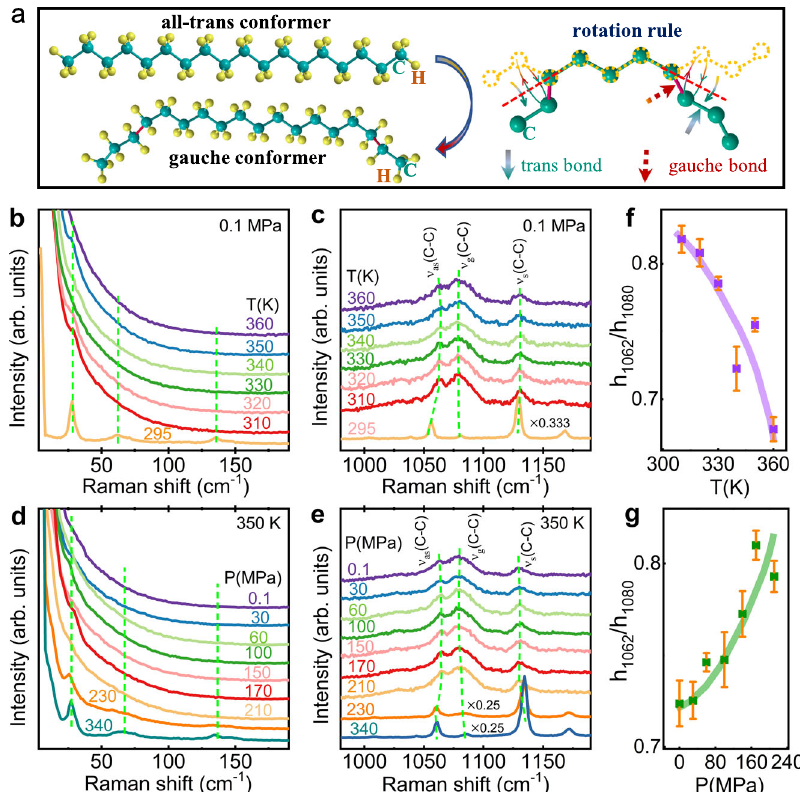
Fig. 3 Raman spectra under different pressures at selected temperatures for C 18 H 38 . a Schematic diagram of structural transformation between the all- trans conformer and gauche conformer. Temperature-dependent Raman spectra in the range Raman shift < 190 cm − 1 ( b ), and 980 cm − 1 < Raman shift < 1190 cm − 1 ( c ); pressure-dependent Raman spectra in the range Raman shift < 190 cm − 1 ( d ), and 980 cm − 1 < Raman shift < 1190 cm − 1 ( e ); the height ratio of the1162 band and 1180 band evolves with temperature ( f ) and pressure ( g ), where the orange error bars were displayed.